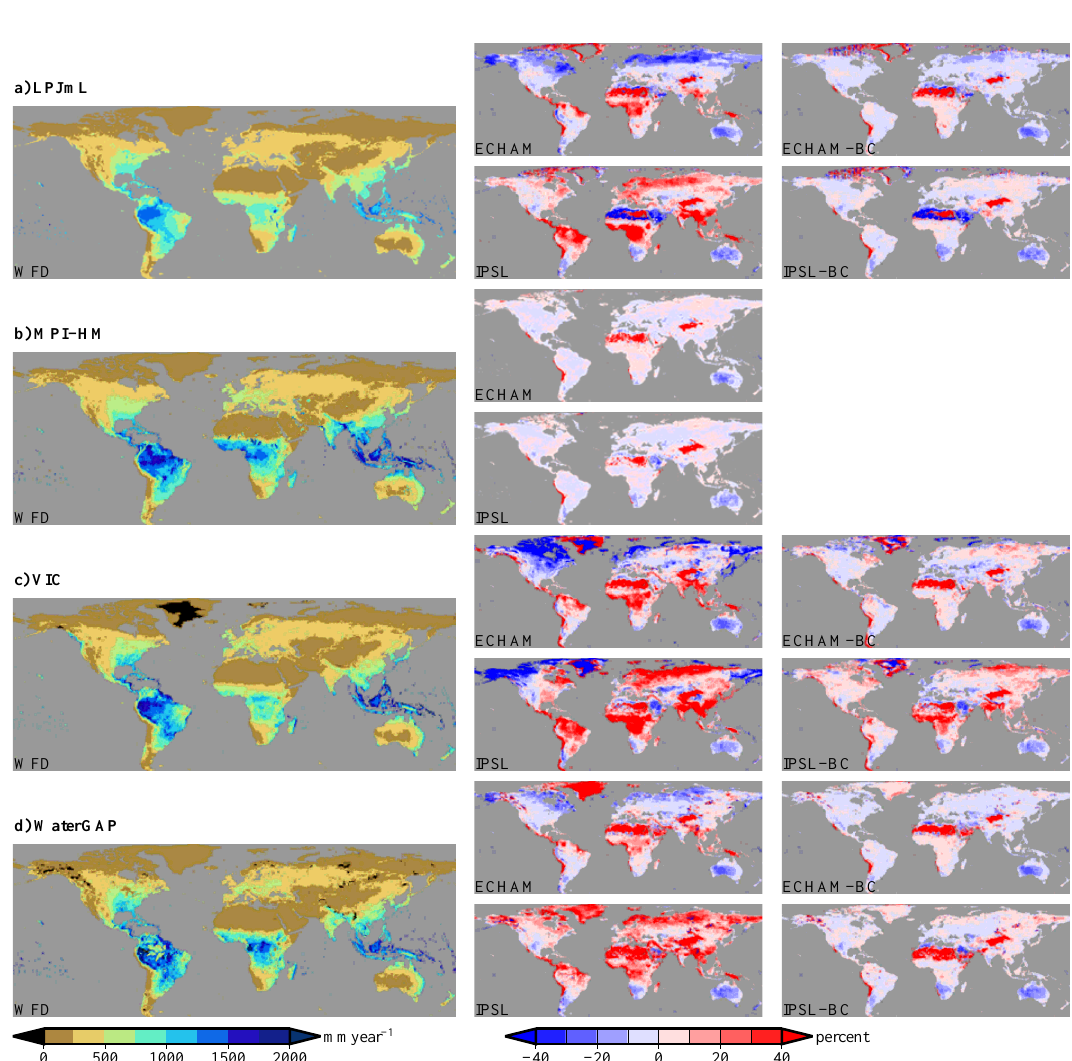
Fig. 3. Mean annual WFD evapotranspiration estimates for the (a) LPJmL, (b) MPI-HM, (c) VIC and (d) WaterGAP models, and WDD anomalies (original and bias corrected results when applicable).